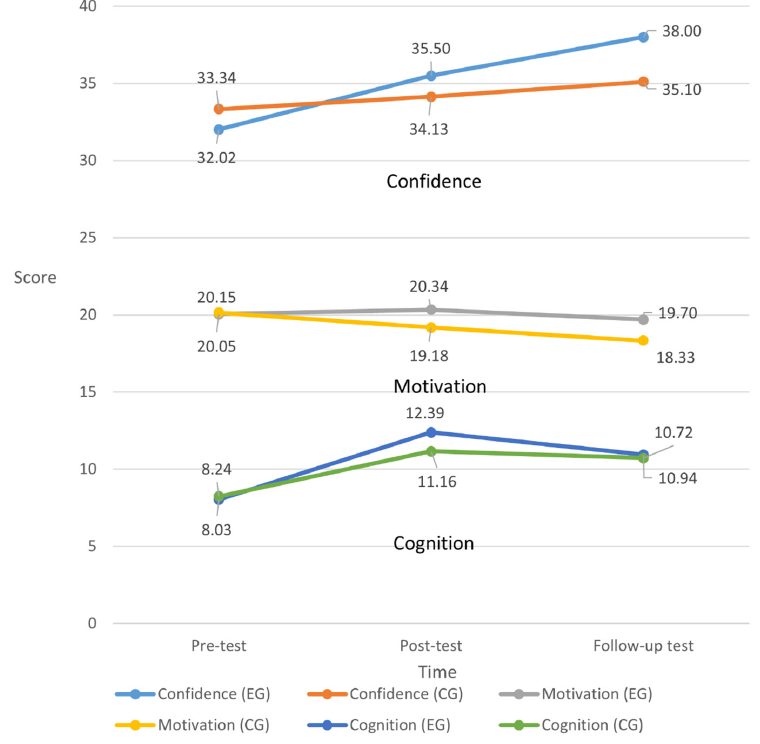
Figure 3. Differences in scores of confidence, motivation, and cognition between the two groups on the three tests (EG = experimental group; CG = comparison group) . the three tests (EG = experimental group; CG = comparison